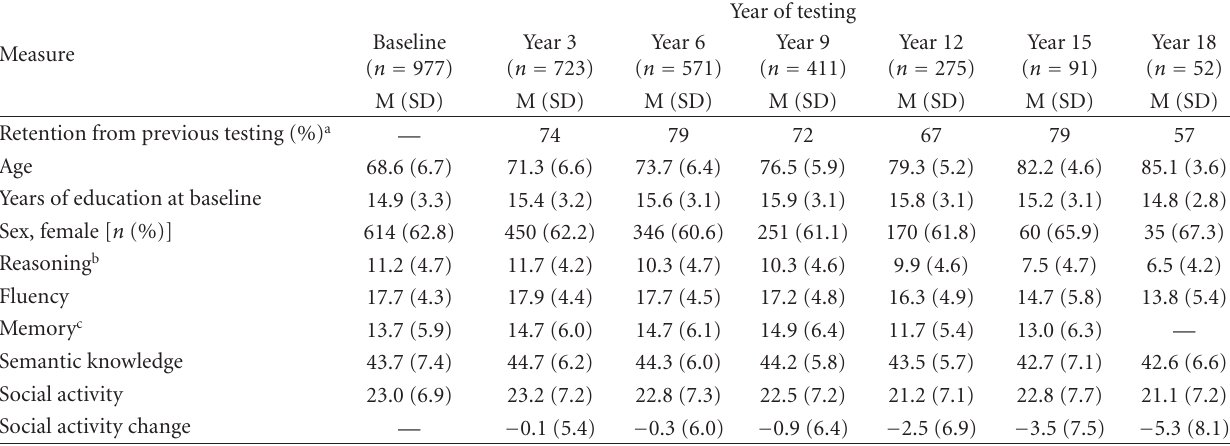
Table 4: VLS participant